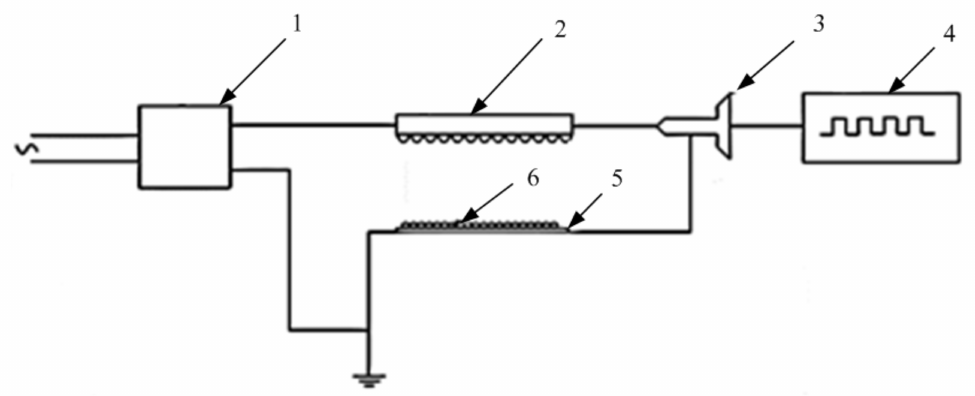
Figure 1. HVEF seed treatment device. 1. Pulsed high-voltage power supply. 2. Arc-shaped prick electrodes. 3. High voltage probe. 4. Oscilloscope. 5. Grounded plate electrode. 6. Cotton